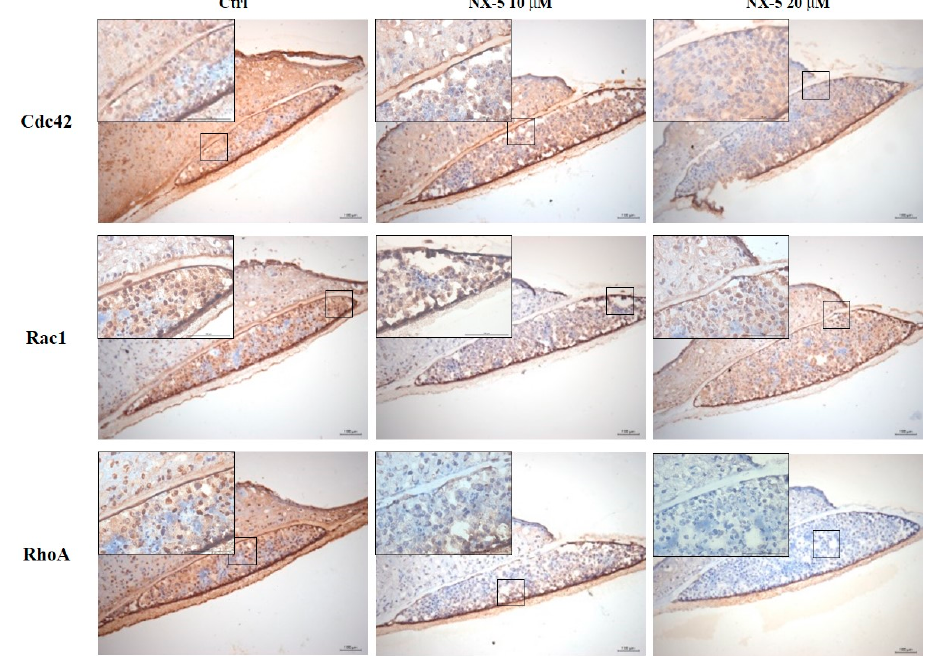
Figure 5. Immunostaining of the 3D melanoma model treated with NecroX-5. The models were treated with 10 μ M or 20 μ M NecroX-5 for 1 day. Immunostaining for expression of Cdc42, Rac1, and RhoA was performed (scale bars = 100–400 μ m, boxed areas = 100 μ m).